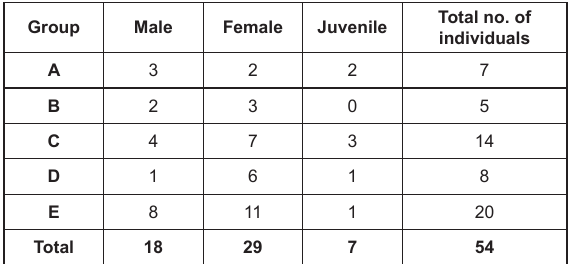
Table 2. Number of Rhesus Macaques killed on the NH-7 along Pench Tiger Reserve Group